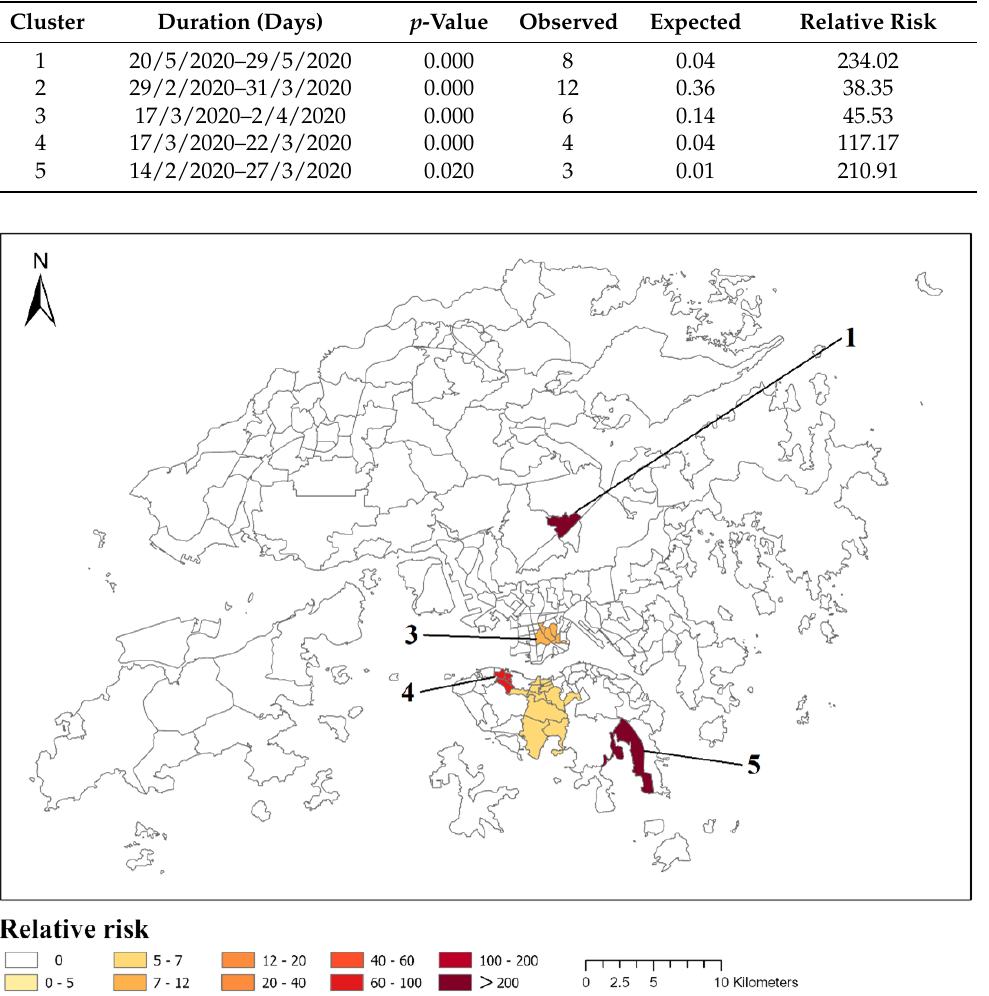
Figure 5. Space–time cluster distribution in stage I at residential locations (In which number 1, 3, 4, 5 indicate the most significant